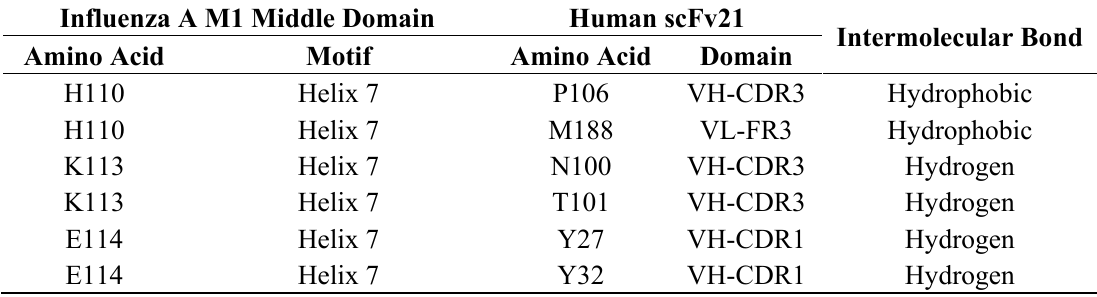
Table 2. Residues of the influenza A virus M1 middle domain bound by the residues and domains of the human